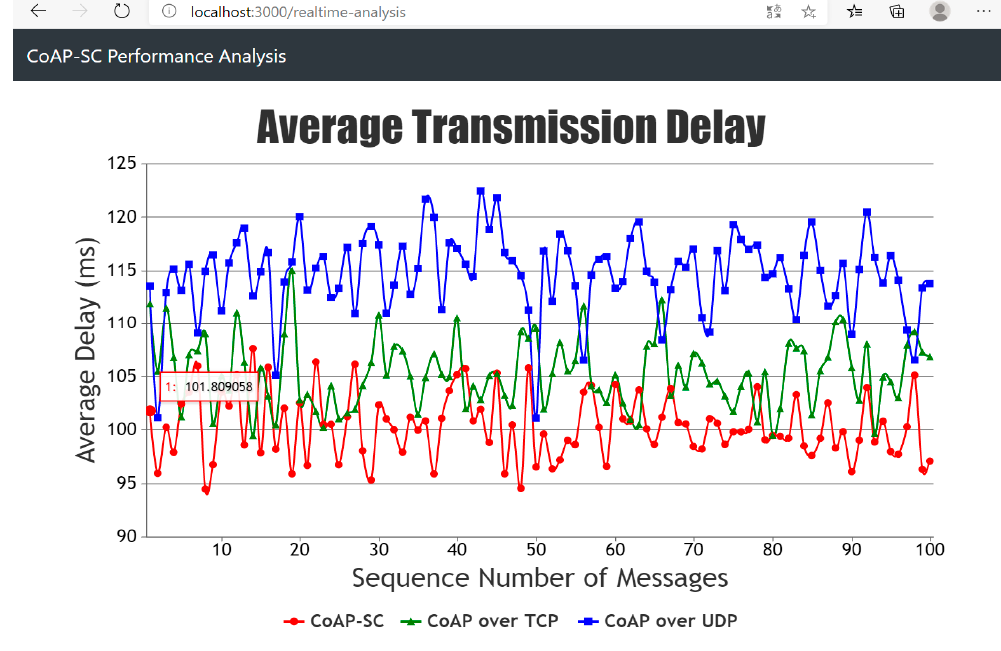
Figure 18. Average transmission delays.